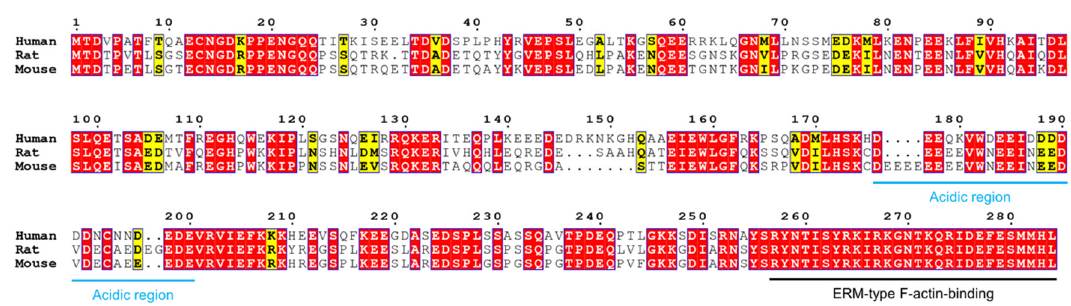
Figure 6. Comparison of human, rat, and mouse Jux. Jux is less conserved than MBP and MOBP, human Jux sharing only ~60% homology to mouse and rat Jux. An acidic region (blue) separates the protein into N- and C-terminal halves, the latter of which contains the fully conserved ERM-type actin binding domain (black). Residue numbering corresponds to human Jux.